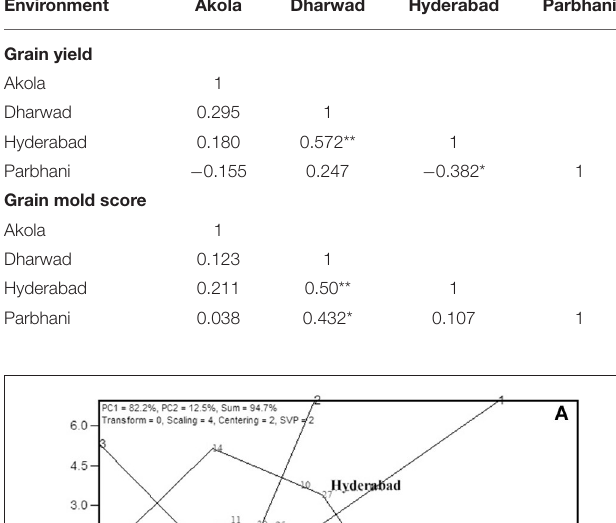
was the best genotype for GY, flowering, and 100-seed